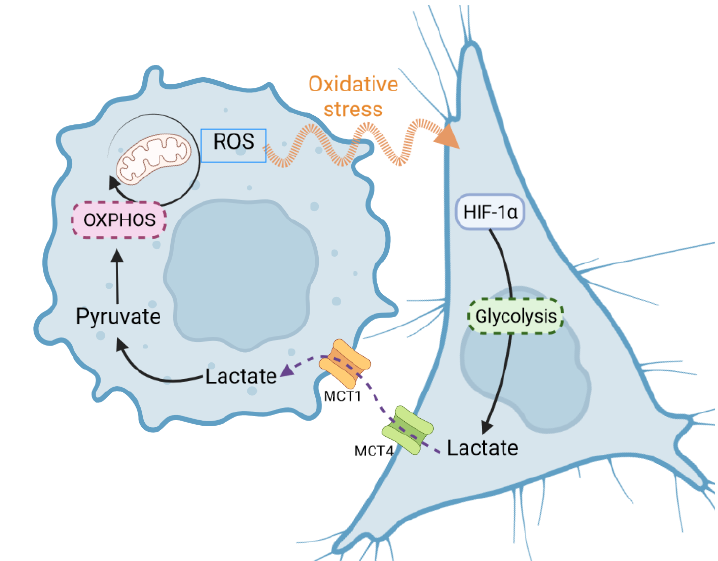
Figure 7. “Reverse Warburg effect”: A cancer cell ( left ) creates oxidative stress in the cancer cell ( right ) by producing ROS (reactive oxygen species). The cell on the right will massively produce lactate which, once excreted, will be used by the cell on the left in the form of pyruvate to replenish the